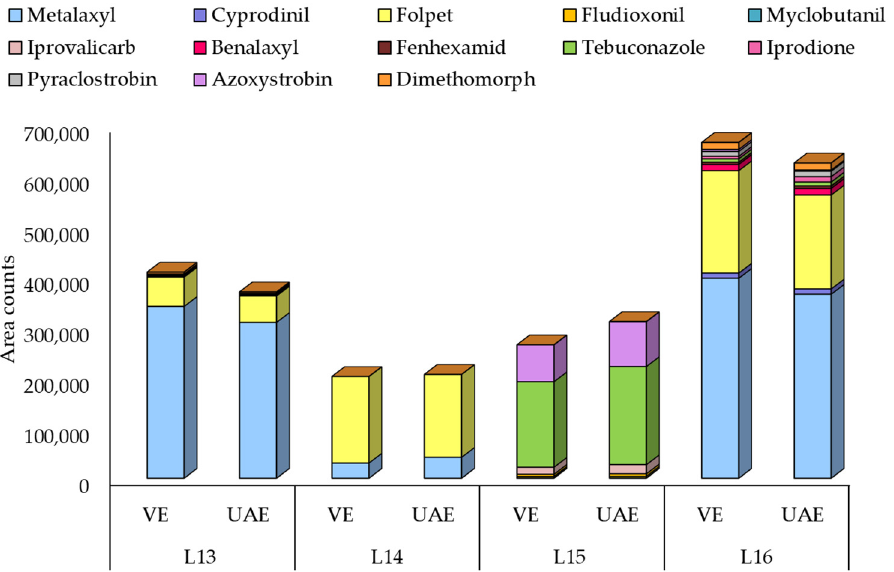
Figure 6. Comparison of the response of fungicides in four contaminated vine leaf samples extracted with UAE and VE. To visualize all the samples in the same scale, responses for L13 and L15 were divided by 10 and 1000, respectively.